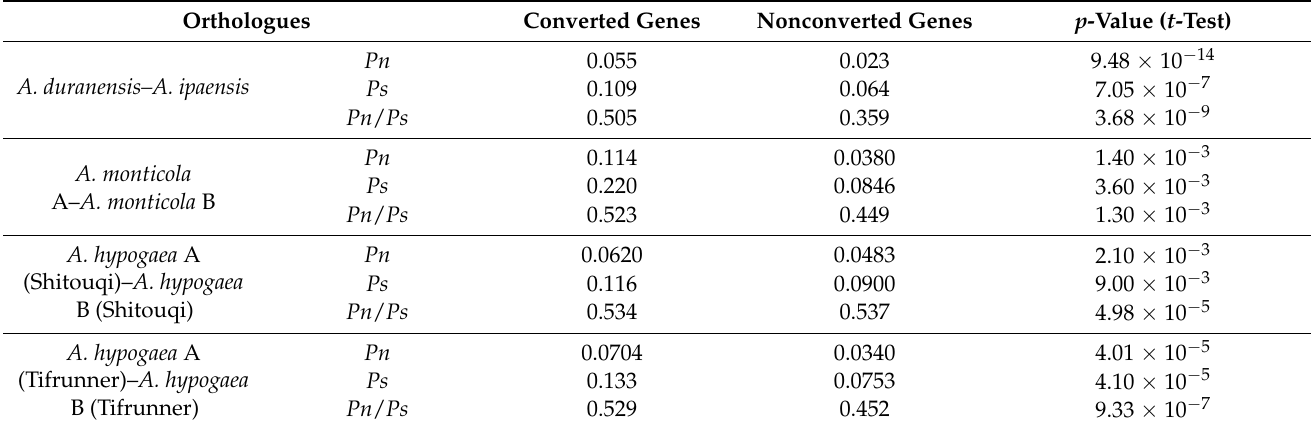
Table 2. Nucleotide substitution rates of quartets in peanut